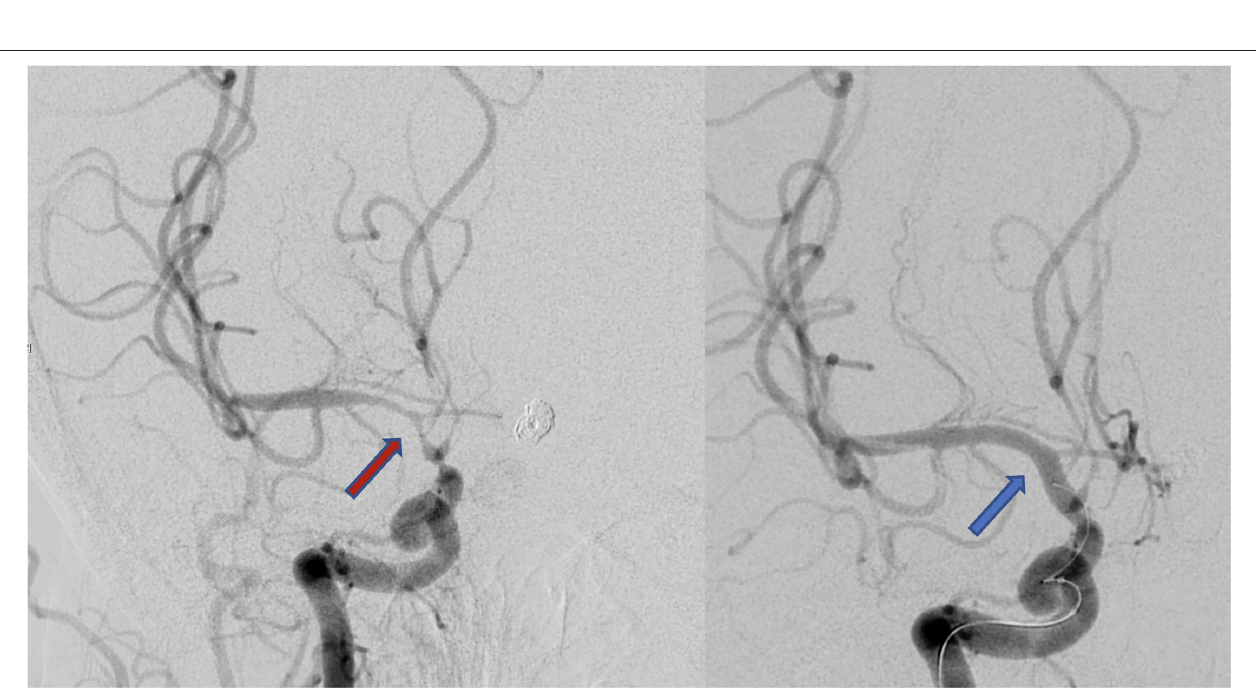
FIGURE 3 | Conventional angiography showing severe vasospasm of the right internal carotic artery, middle cerebral artery, and anterior cerebral artery before (red arrow, left) and after (blue arrow, right) the intervention.